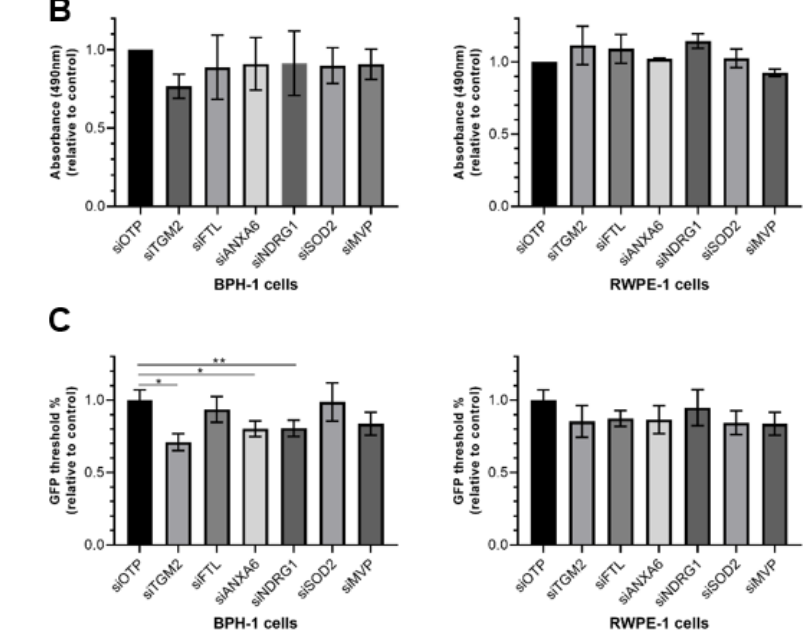
Figure 7. Functional interrogation of selected candidates via proliferation assays. ( A ) Representative Western blot images demonstrating siRNA-mediated knockdown. ( B ) MTS assays for BPH-1 and RWPE-1 benign prostate epithelial cells after 72 h of monoculture. Data are expressed relative to 0 h and normalized to the control (siOTP). ( C ) Epithelial cell proliferation in co-culture. GFP-positive BPH-1 and RWPE-1 cells were cultured with GFP-negative CAF cells for 72 h. GFP fluorescence intensity was used as a measure of epithelial cell number, relative to 0 h and normalized to the control. Mean ± SEM, n = 3. One-way ANOVA. * p < 0.05, ** p < 0.01.